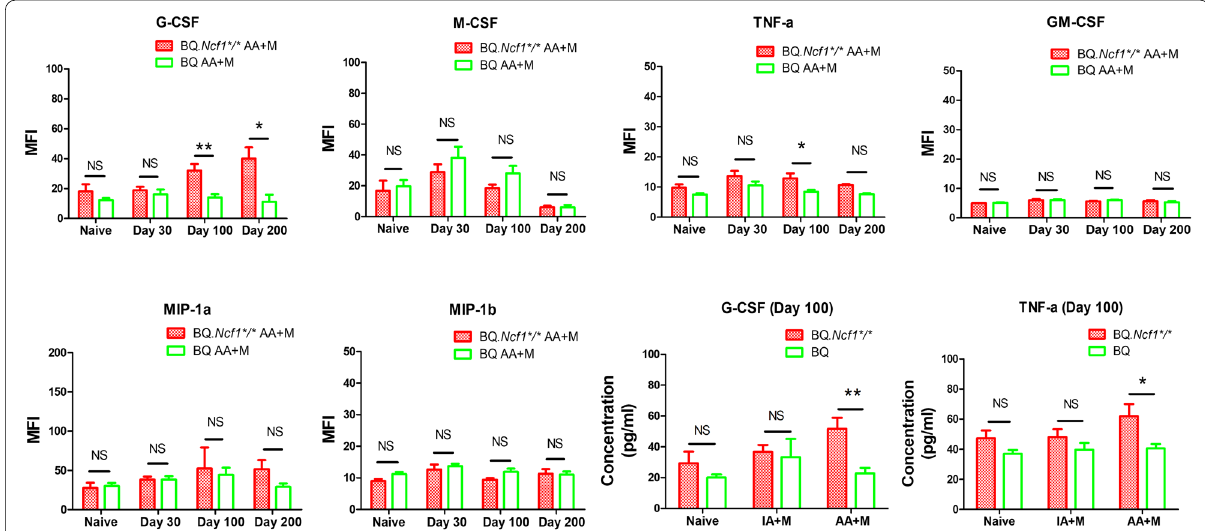
Fig. 5 Levels of inflammatory cytokines in the chronic phase of mCAIA in BQ. Ncf1 */* mice. Serum G-CSF, M-CSF, GM-CSF, TNF-α, MIP-1a, and MIP-1b in mCAIA on days 0 (naïve) ( n 5–6), 30 ( n 8), 100 ( n 8–10) and 200 ( n 3–4) and serum G-CSF and TNF-αon day 100 in AA = = = = IA M ( n 4), P M ( n 4) and naïve group ( n 6–8). (AA: anti-COL2 antibodies; IA: isotype antibodies; M: mannan; P: PBS). The data shown are + = + = = mean SEM. The two-tailed Mann-Whitney U test was used to calculate the level of significance. BQ. Ncf1 */* AA ± p < 0.01; ***, p < 0.001